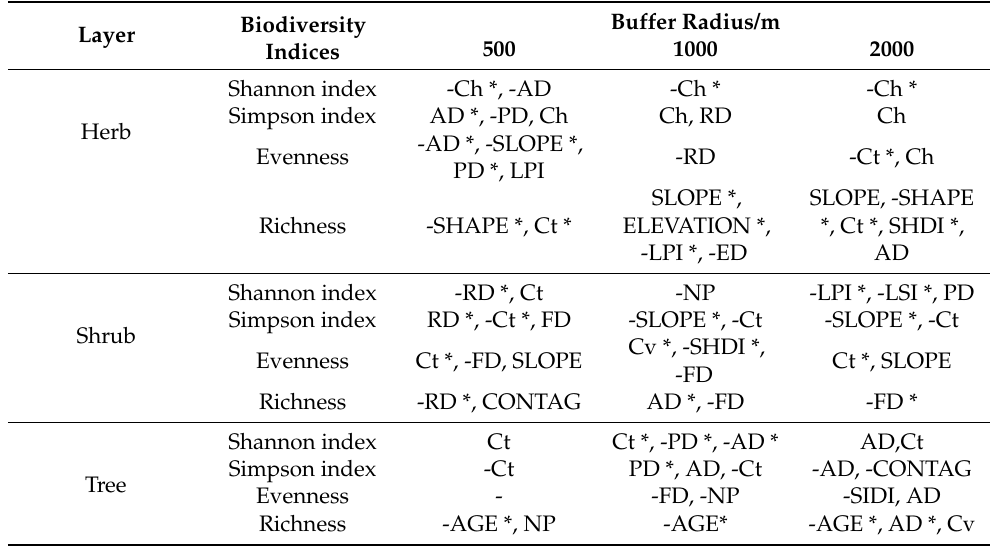
Table 5. The multiple regression of landscape heterogeneity, community structure, and topographic factors on diversity indices and richness index in tree, shrub, and herb layers. Buffer Radius/m Biodiversity Layer 500 1000 2000 Indices Shannon index -Ch *, -AD -Ch * -Ch * Simpson index AD *, -PD, Ch Ch, RD Ch Herb -AD *, -SLOPE *, Evenness -RD -Ct *, Ch PD *, LPI SLOPE *, SLOPE, -SHAPE Richness -SHAPE *, Ct * ELEVATION *, *, Ct *, SHDI *, -LPI *, -ED AD Shannon index -RD *, Ct -NP -LPI *, -LSI *, PD Simpson index RD *, -Ct *, FD -SLOPE *, -Ct -SLOPE *, -Ct Shrub Cv *, -SHDI *, Evenness Ct *, -FD, SLOPE Ct *, SLOPE -FD Richness -RD *, CONTAG AD *, -FD -FD * Shannon index Ct Ct *, -PD *, -AD * AD,Ct Simpson index -Ct PD *, AD, -Ct -AD, -CONTAG Tree Evenness - -FD, -NP -SIDI, AD Richness -AGE *, NP -AGE* -AGE *, AD *,